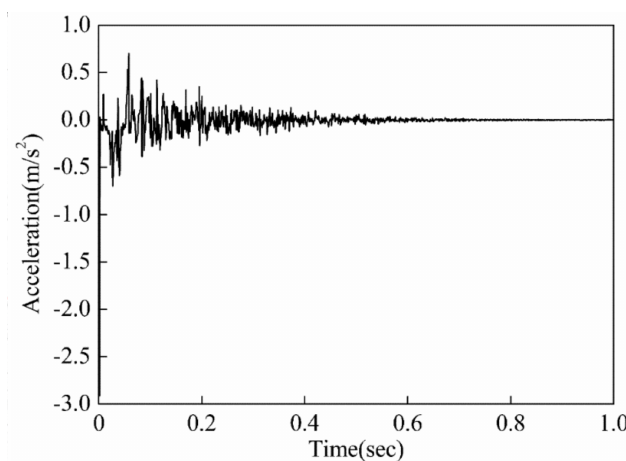
Figure 7. Estimation of phase.